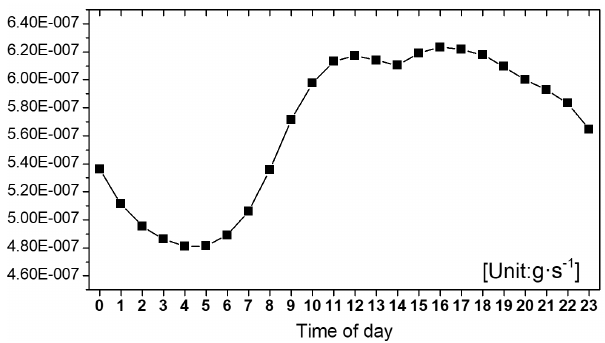
Figure 6. Hourly variation in primary PM 2 . 5 emission sources in Beijing (monthly